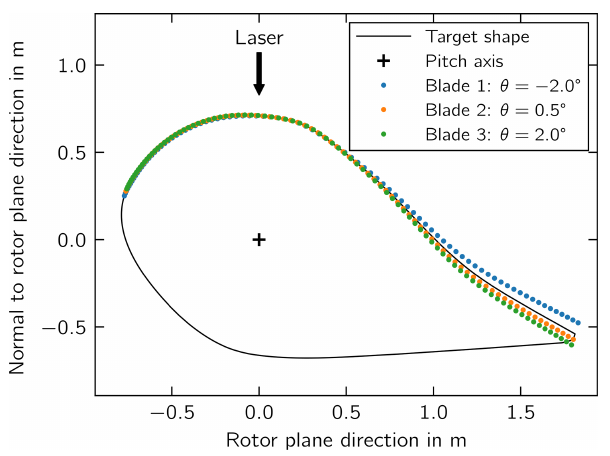
Figure 3. Example of measured shapes of the three blades within the rotor; view from the blade tip.